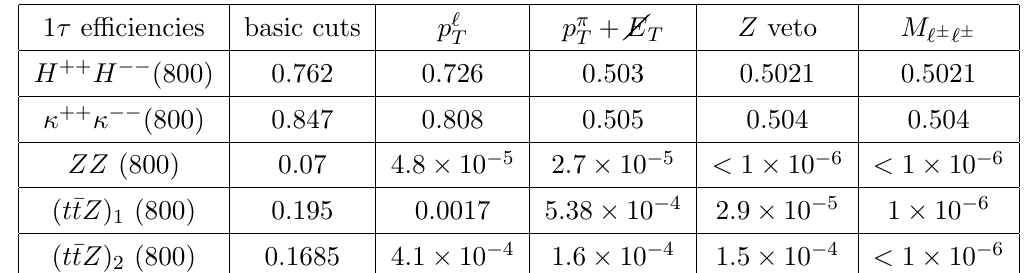
Table 2 . The cut e(cid:14)ciencies for 1 (cid:28) signal ( pp ! H ++ H (cid:0)(cid:0) ! (cid:28) (cid:6) ‘ (cid:6) ‘ (cid:7) ‘ (cid:7) ) and the SM backgrounds after accumulated cuts with (cid:28) (cid:6) ! (cid:25) (cid:6)